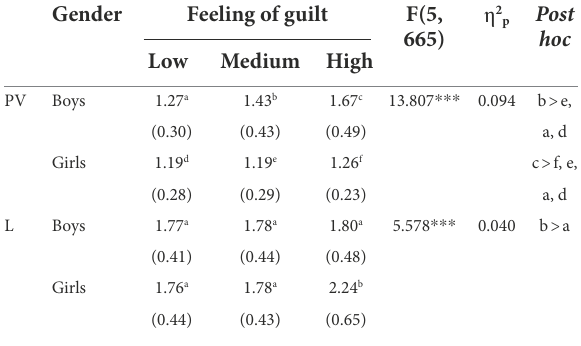
TABLE 3 Means, standard deviations, F values, and Bonferroni post hoc test for the guilt groups.